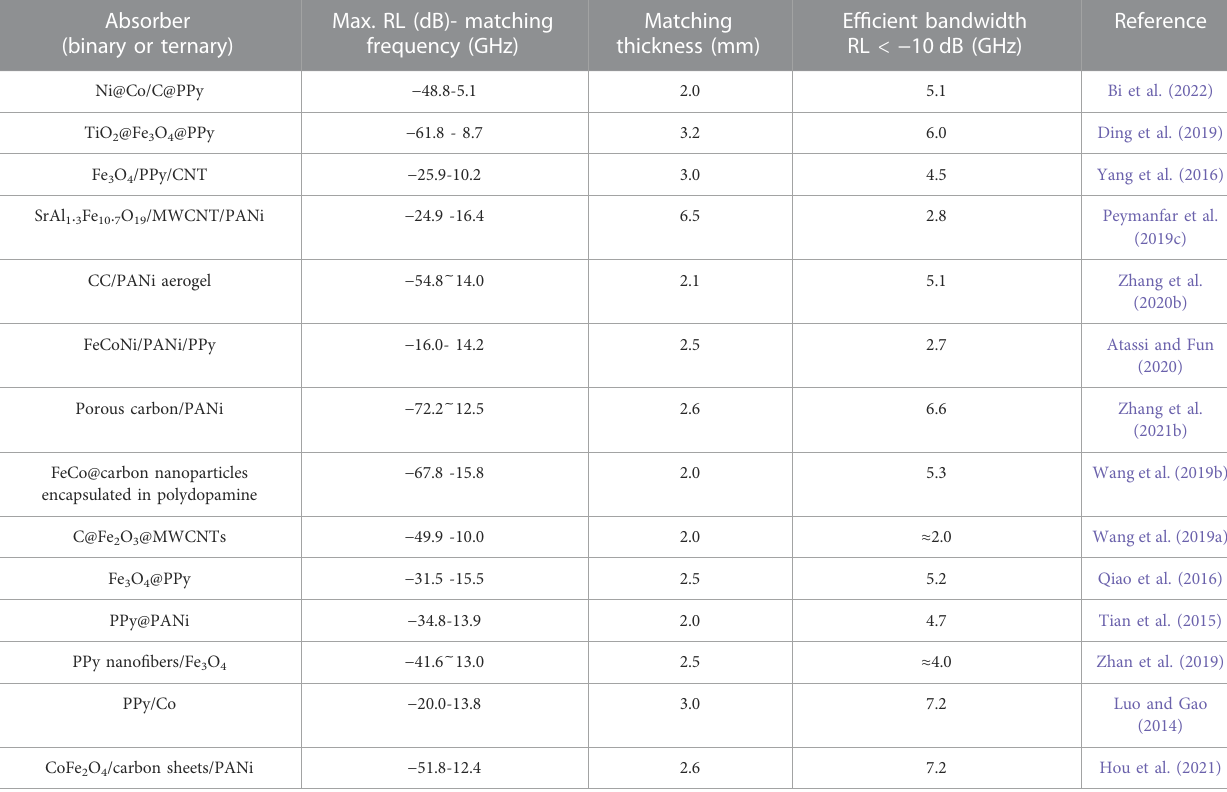
TABLE 1 Microwave absorption performance of organic conductive polymer composites. Absorber (binary or ternary)